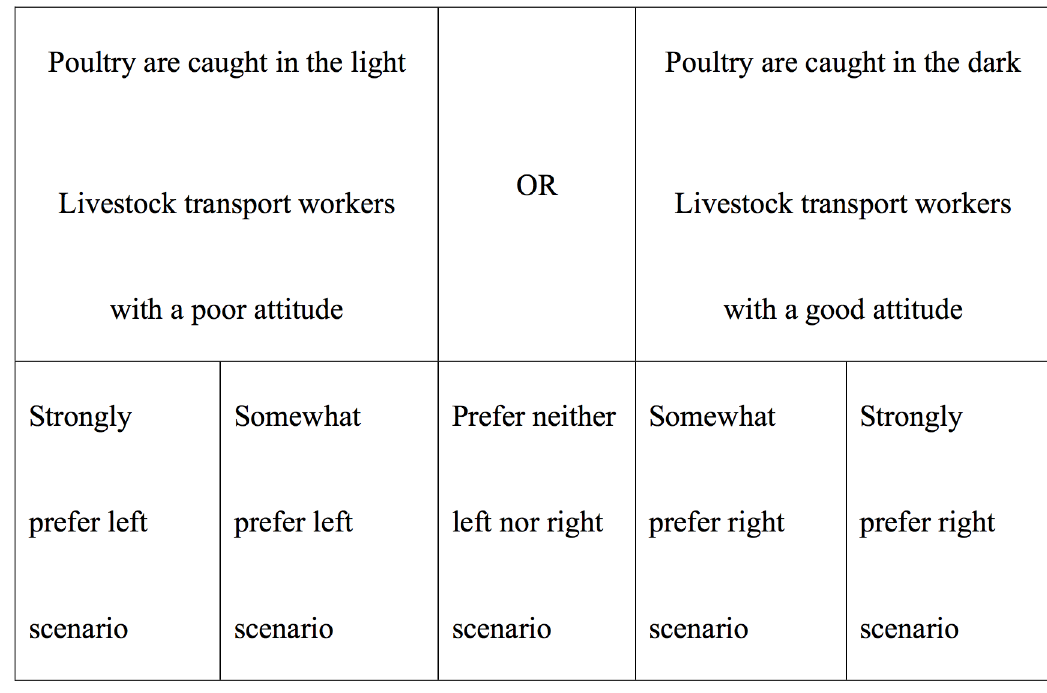
Fig 1. Example of combination